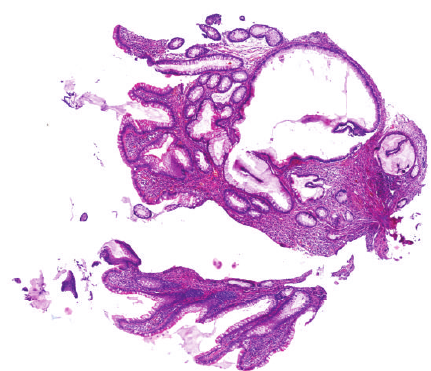
Figure 11: Juvenile polyp of jejunal mucosa shows shortening of villi, dilation of crypts and mild inflammation (hematoxylin-eosin, original magnification